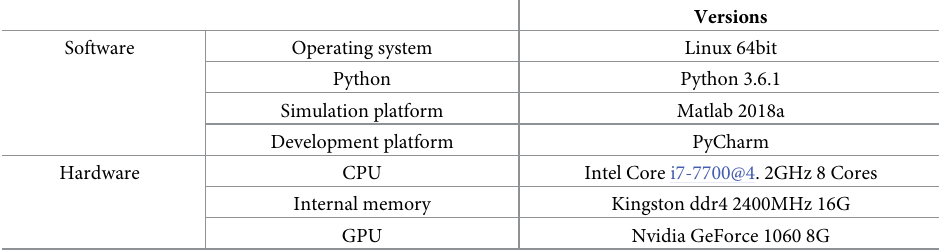
Table 1. Modeling tools for simulation experiment.